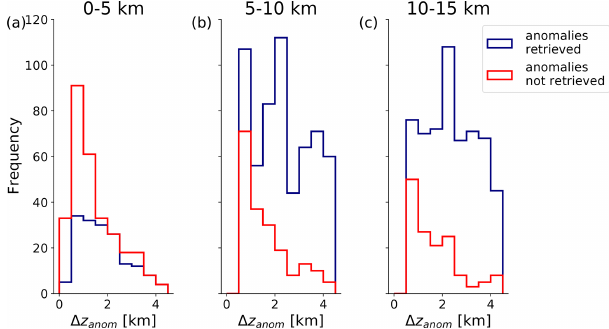
Figure 9. Frequency distributions of moisture anomaly thickness of the tropical ocean reference dataset, split up into cases where a moisture anomaly could be retrieved and could not be retrieved. Panels (a) , (b) and (c) reflect three altitude regions, namely the lower (0–5km), mid (5–10km) and upper (10–15km)